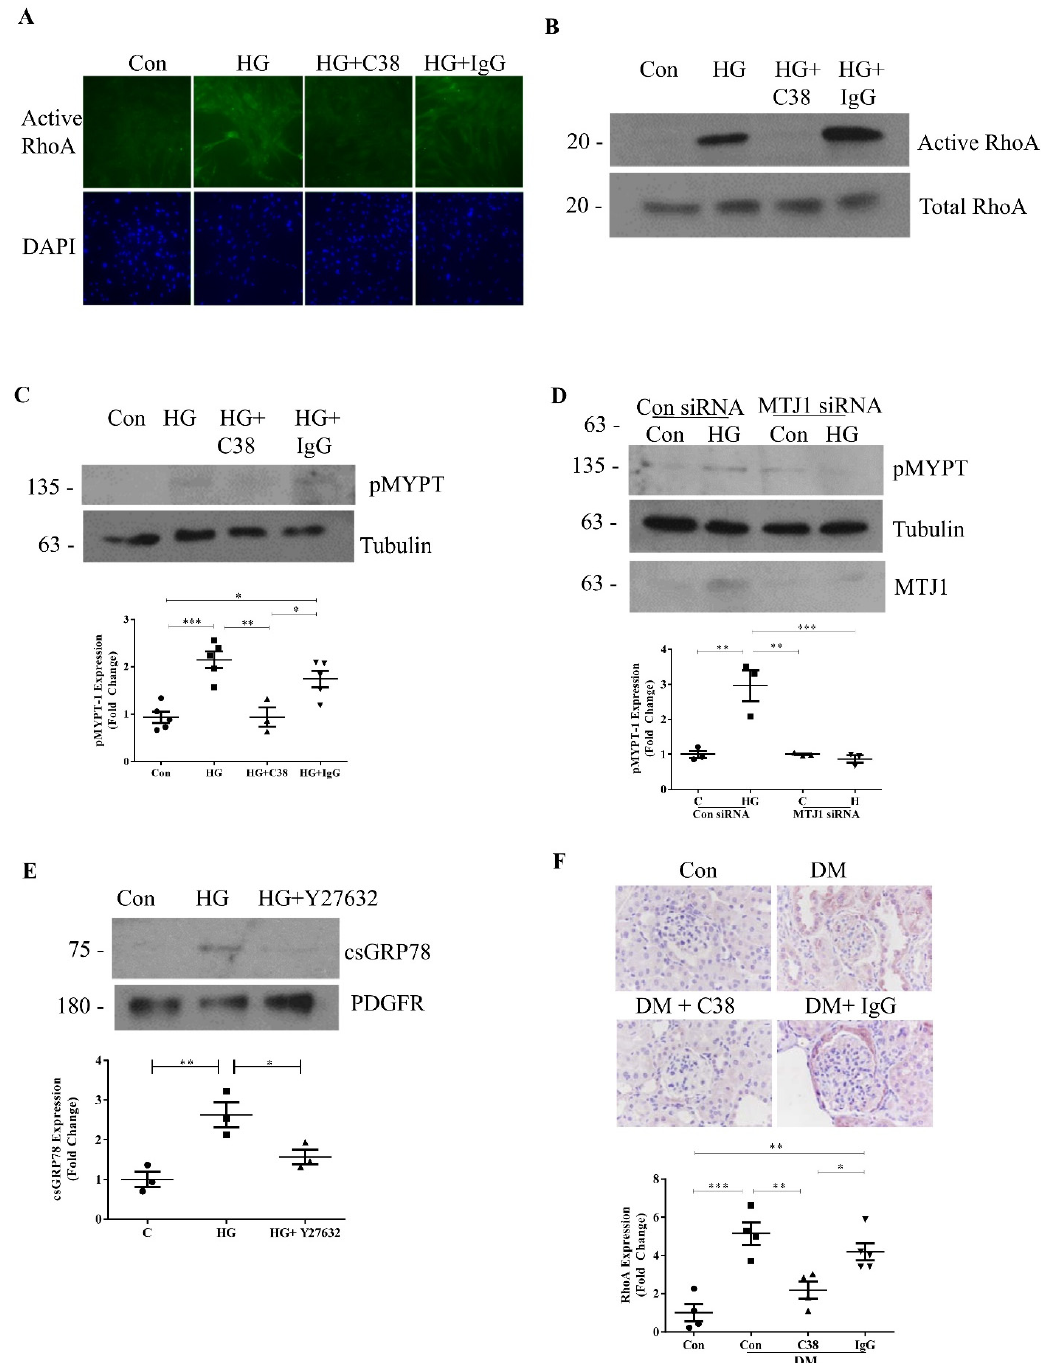
Figure 2. Cell-surface GRP78 mediates HG-induced RhoA activation. Inhibition of cell-surface GRP78 with an antibody specific to its C-terminus (C38, 2 μ g), but not control IgG, attenuated HG-induced RhoA activation, assessed by immunofluorescence using an active RhoA-specific antibody ( A ) and pull-down and immunoblotting of active RhoA ( B ). ( C ) Immunoblotting confirmed inhibition of HG-induced Rho-kinase activation by C38, assessed by phosphorylation of MYPT ( n = 5, * p < 0.05, ** p < 0.01, *** p < 0.001). ( D ) siRNA knockdown of MTJ-1 to prevent GRP78 localization to the cell-surface also inhibited Rho-kinase activation by HG ( n = 3, ** p < 0.01, *** p < 0.001). ( E ) Conversely, HG (48 h)-induced cell-surface GRP78 localization was attenuated by Rho-kinase inhibition with Y27632 (10 µ M) ( n = 3, * p < 0.05, ** p < 0.01). ( F ) RhoA activation was assessed by immunohistochemistry in kidneys of uninephrectomized CD1 mice made diabetic by streptozotocin. Activation was significantly inhibited by cell-surface GRP78 inhibition with C38 compared to control IgG ( n = 4, * p < 0.05, ** p < 0.01, *** p <